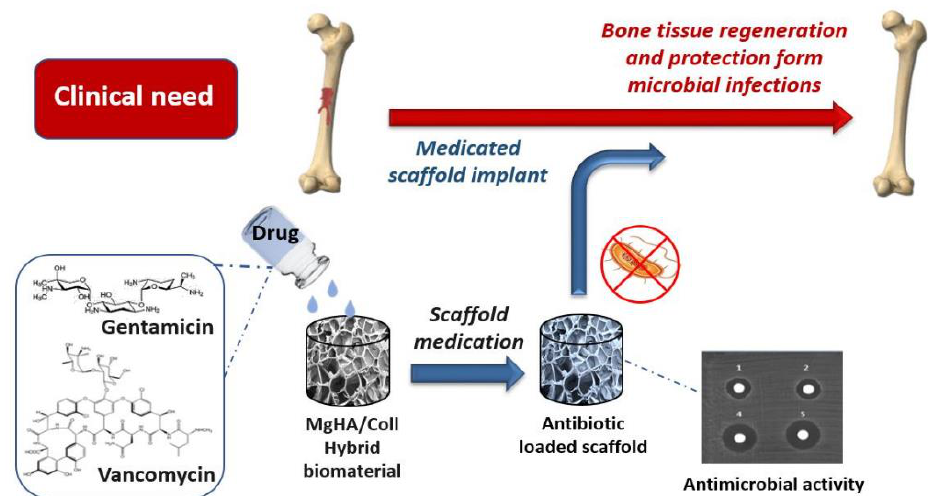
Figure 6. Schematic illustration of the loading of antibiotics within hybrid scaffolds based on col- lagen and magnesium-doped hydroxyapatite. Two different antibiotics, namely gentamicin and vancomycin, were introduced during biomineralization of collagen. Antibiotics proved to be tightly associated within the biomineralized scaffolds. These scaffolds were able to provide a piecemeal release of antibiotics, avoiding microbial colonization (and therefore avoiding infections) and simul- taneously promoting bone tissue regeneration. The figure is reproduced from Medicated Hydroxya- patite/Collagen Hybrid Scaffolds for Bone Regeneration and Local Antimicrobial Therapy to Prevent Bone Infections by M. Mulazzi et al., 2021, Pharmaceutics, 13 (7), 1090 (doi:10.3390/pharmaceutics13071090) (Under a Creative Commons Attribution 4.0 International